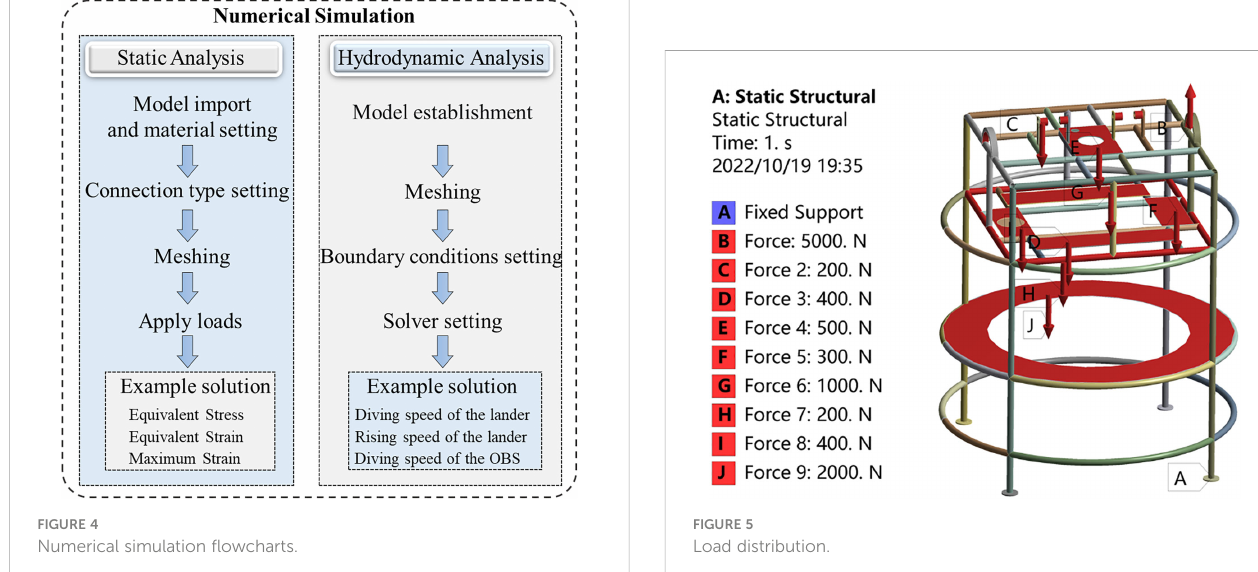
FIGURE 4 Numerical simulation fl owcharts.